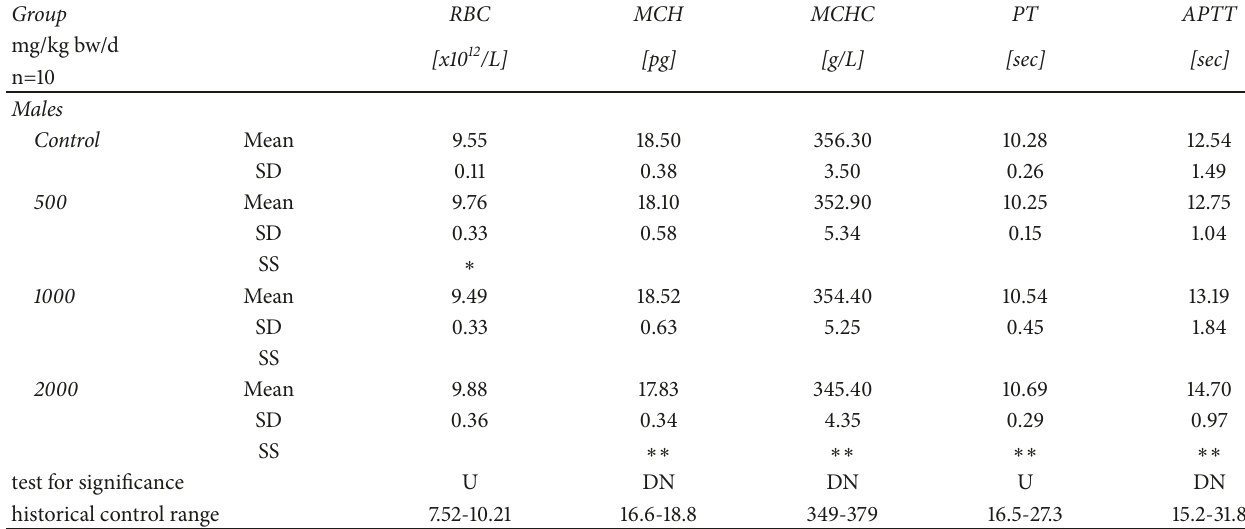
Table 5: Summary of relevant hematological findings for male rats in the 90-day